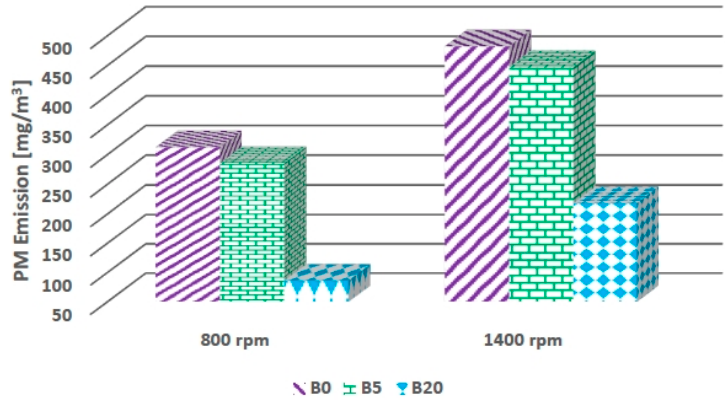
Figure 11. Variation of particulate matter emission with speeds.